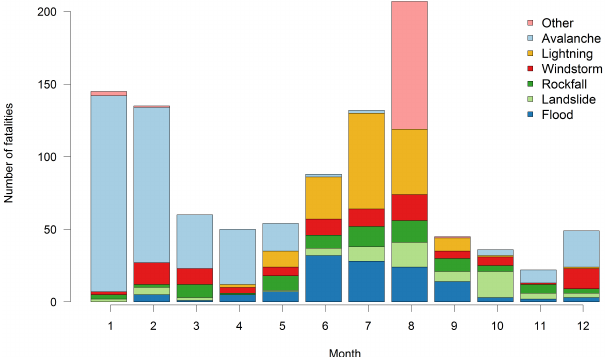
Figure 5. Monthly distribution of natural hazard fatalities in Switzerland from 1946 to 2015 (sum over study period). The dif- ferent colours indicate the seven process categories defined for this